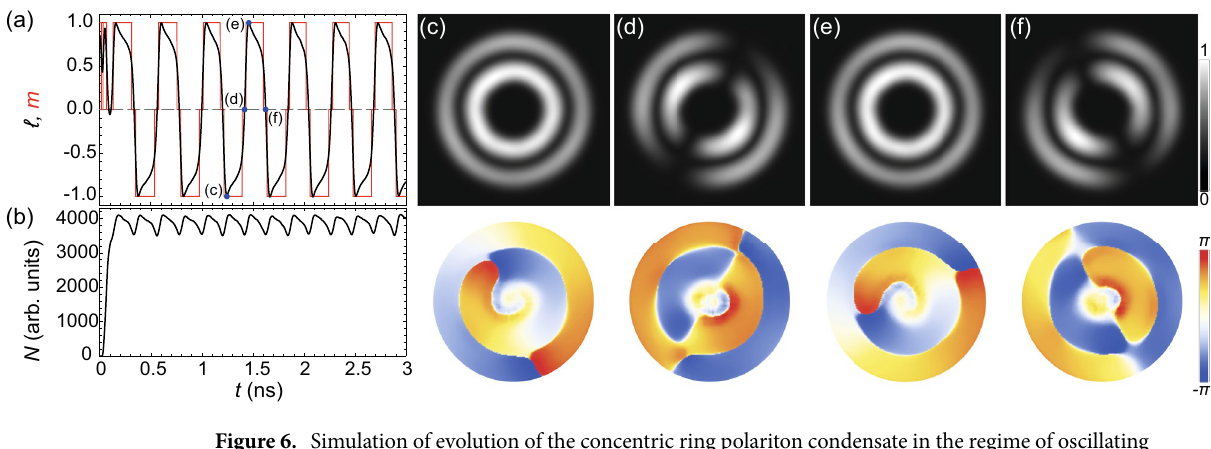
Figure 6. Simulation of evolution of the concentric ring polariton condensate in the regime of oscillating vorticity. Variation in time of OAM ℓ( t ) (black curves) and the winding number m ( t ) (red curves) ( a ), and occupation number of the polariton condensate N ( t ) ( b ). Panels ( c – f ) show distribution in the micropillar plane of the density (top) and phase (bottom) of the polariton condensates at time moments indicated by blue dots in 1 ( c ), m 0 and d t ℓ < 0 ( d ), m 1 ( e ), m 0 and d t ℓ > 0 ( f panel ( a ), corresponding to m = − = = =